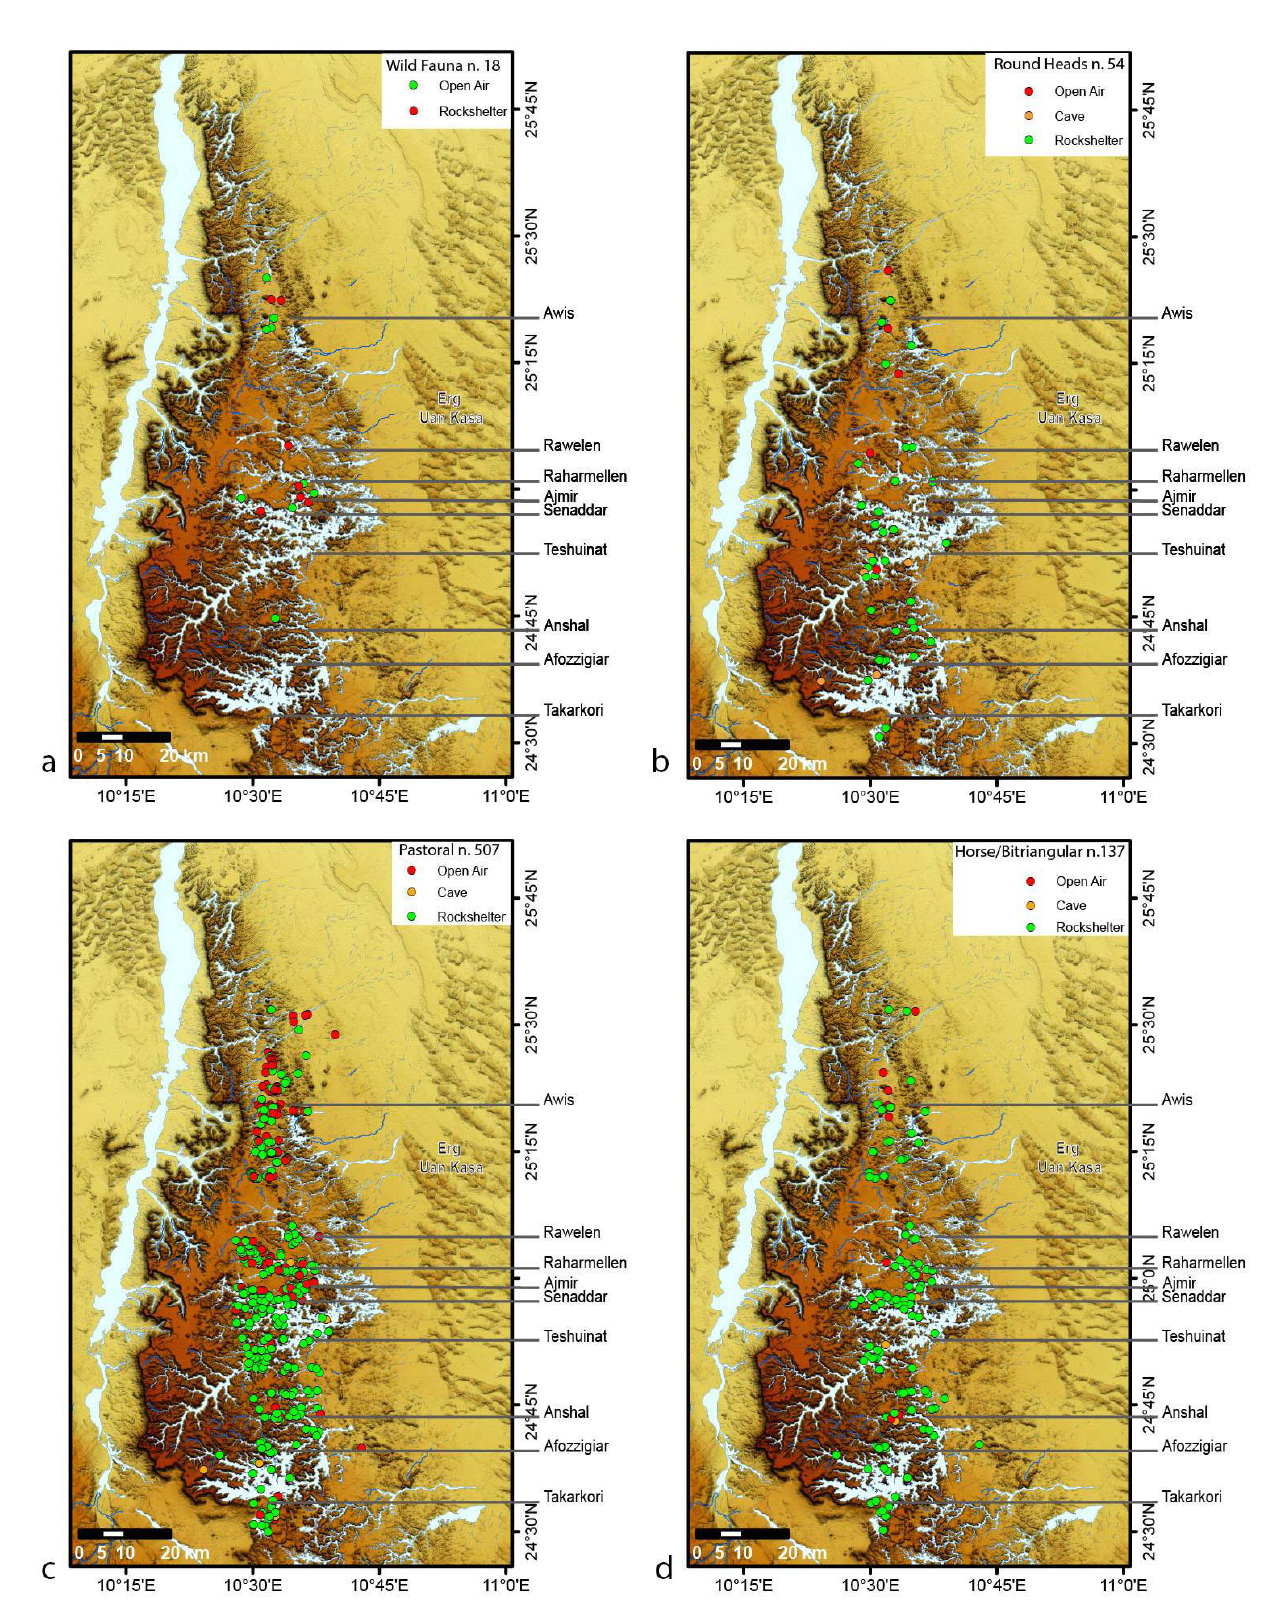
Figure 12. Distributions of stylistic testimonies: (a) Wild Fauna. (b) Round Heads. (c) Pastoral. (d) Horse/Bitriangular. Site dots are distinguished by type: Open Air, Cave,